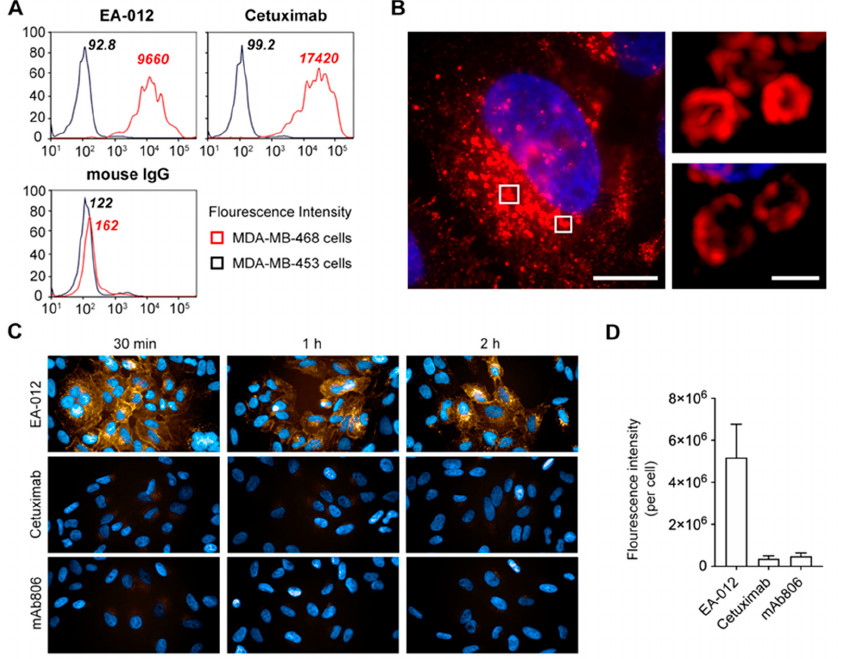
Figure 5. EA-012 could induce catastrophic internalization. ( A ) MDA-MB-468 cells was used as EGFR positive cells, with MDA-MB-453 as negative cells. Cells were stained with a negative control antibody (mouse IgG), a positive control antibody (Cetuximab) and EA-012. Then cells were analyzed by fluorescence activated cell sorting (FACS). ( B ) 10 μ g/mL EA-012 was treated on Hep3B cells. Cell nuclei were dyed by Hoechst (blue). Surface rendering was generated from Imaris. Scale bars in left, 10 μ m, in right, 1 μ m. ( C,D ) EA-012, Cetuximab or mAb806 (red) treated on Hep3B cells for different times and the cells were imaged by high content imaging system. Cell nuclei were counterstained with Hoechst (blue). Magnification ×60. The internalization of EA-012, Cetuximab or mAb806 was analyzed by Harmony software. All data are means ± SD.